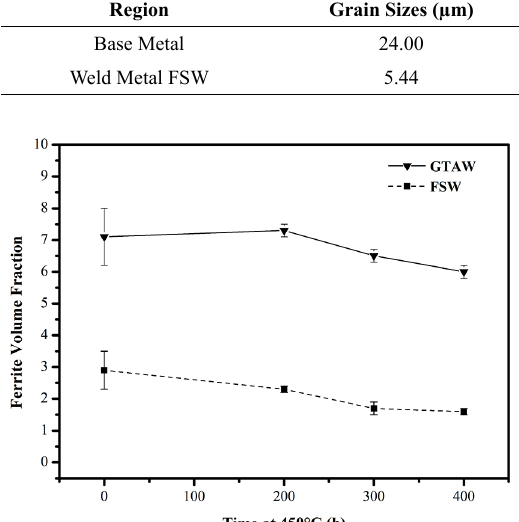
Table 13. Grain sizes calculated by the method of the intercepts, with images obtained by OM. Region